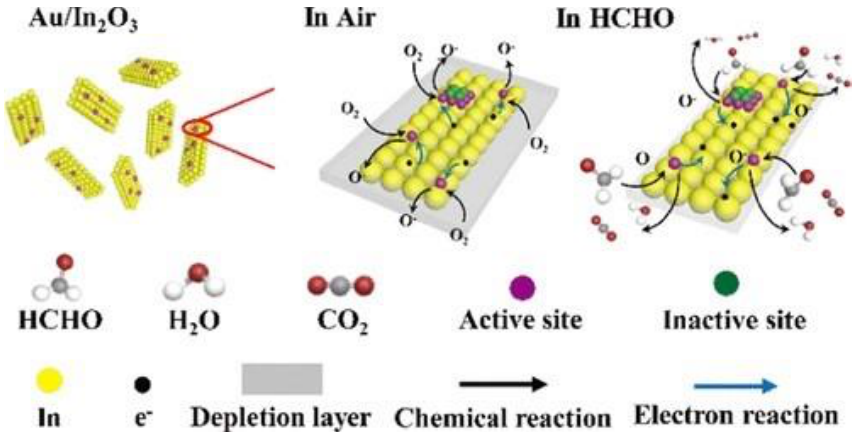
Figure 9. Schematic diagram of the HCHO sensing mechanism on Au/In 2 O 3